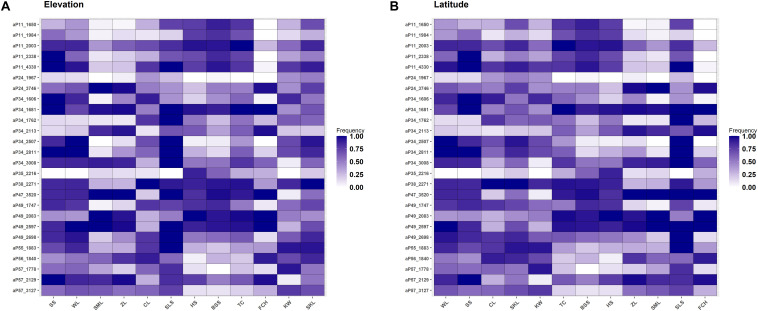
Heatmap of allele frequencies of the 34 outlier loci identified. The sequence of populations was arranged according to (A) elevation or (B) latitude.